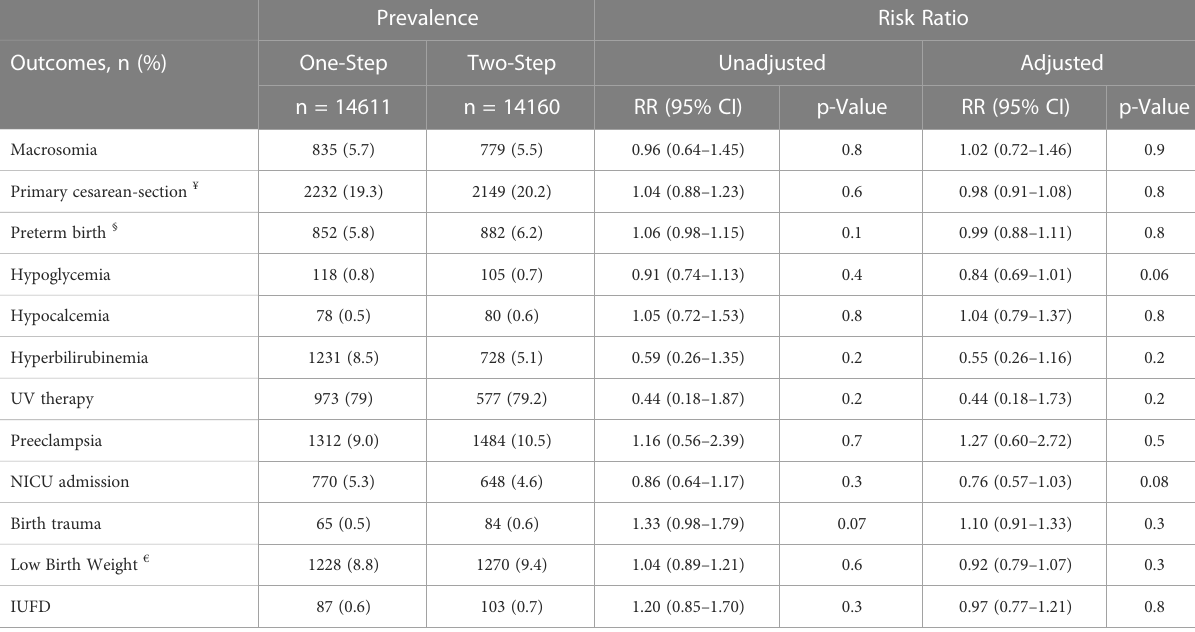
TABLE 2 The prevalence of maternal and neonatal outcomes in pregnant women based on type of GDM screening approach and risk ratio (95% CI), comparing those outcomes in Two-Step versus One-Step screening. Prevalence Risk Ratio